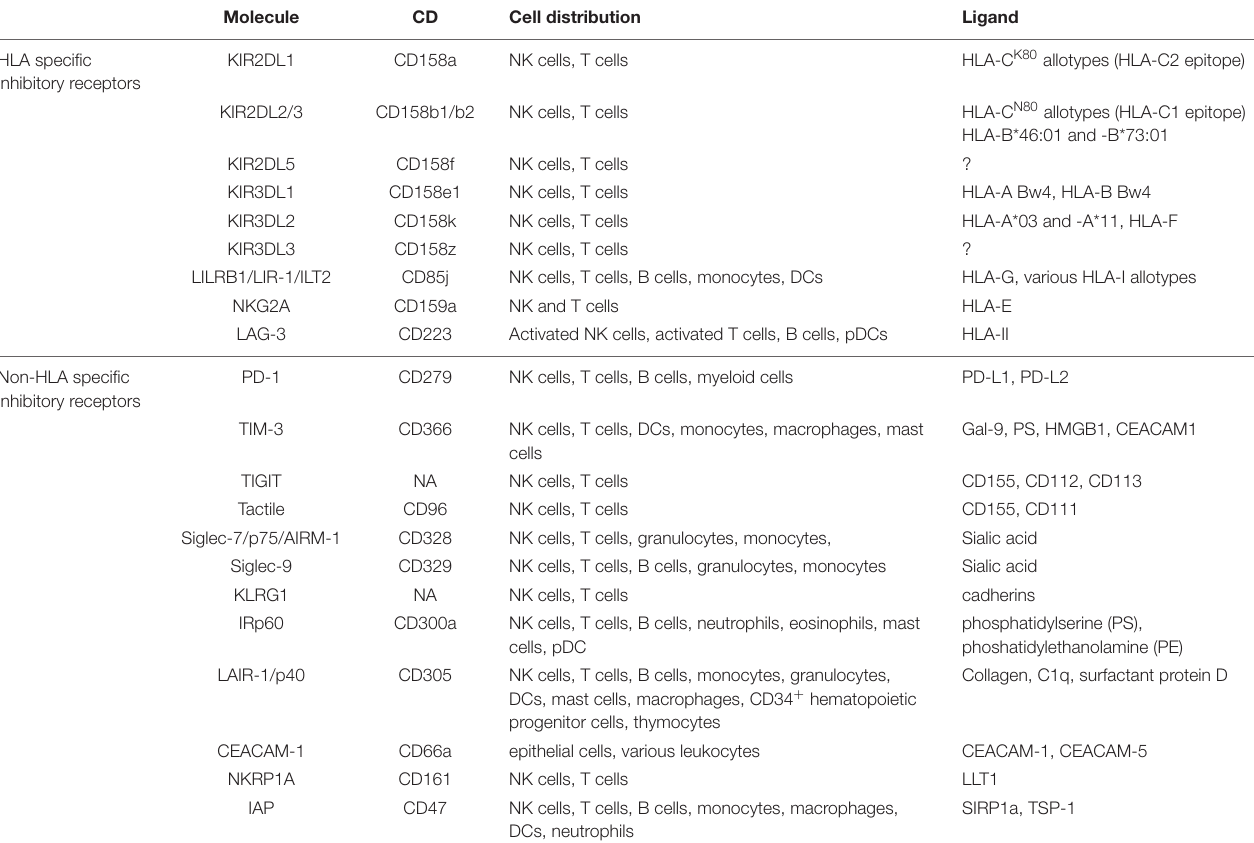
TABLE 1 | HLA-I specific and non-HLA-I specific inhibitory receptors, their distribution and ligands. Molecule CD Cell